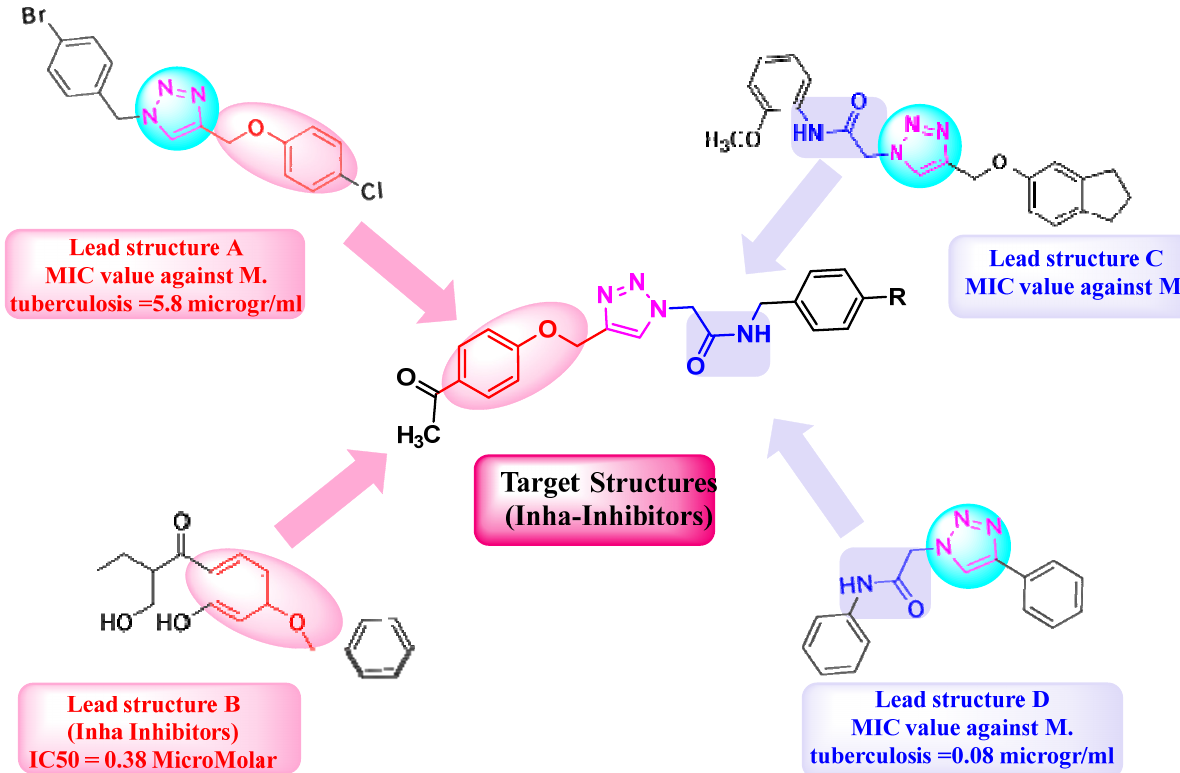
Figure 3. Ligand-based design of target structure.